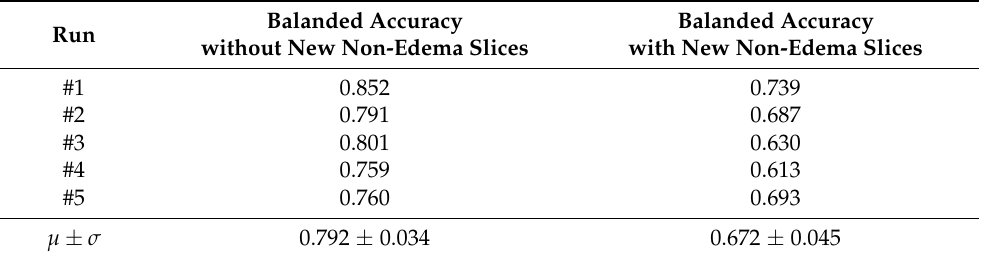
Table 5. Results on the test set (mean ( µ ) and standard deviation ( σ )) using 5 different distributions of the